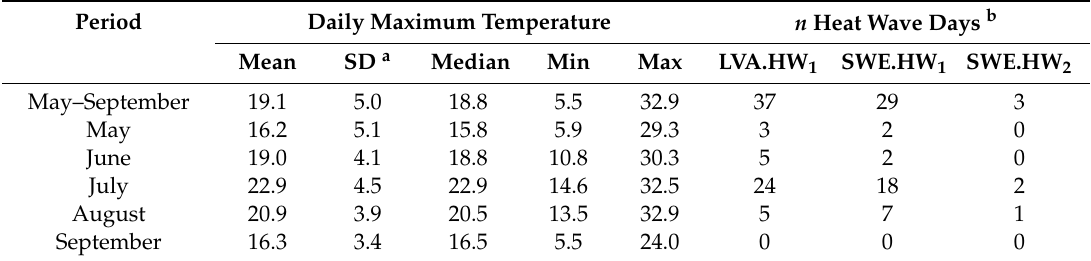
Table 2. Daily mean, maximum temperatures and number of heat wave days for the summer months May to September from 2009 to 2015 in Riga. Period Daily Maximum Temperature n Heat Wave Days b